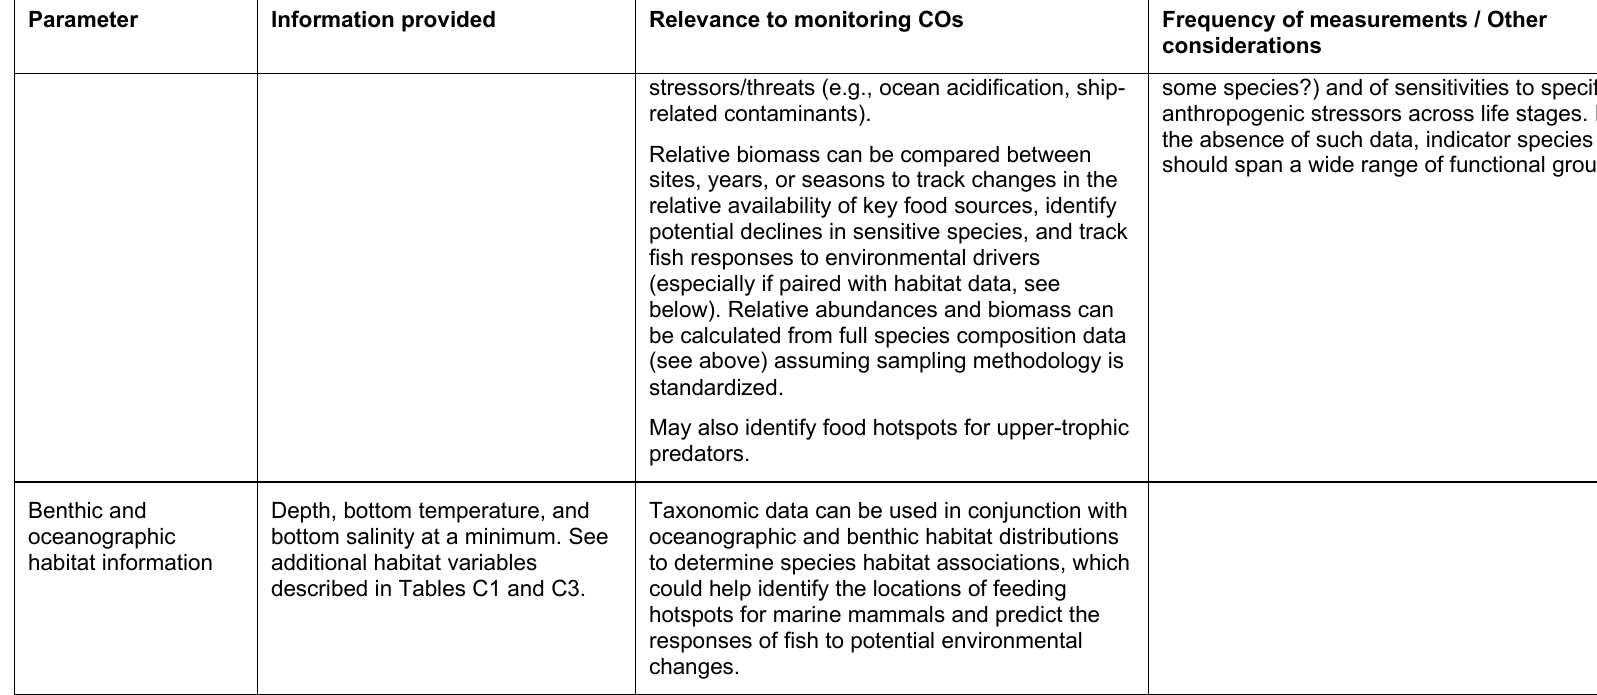
Table C6.6. Key measurement parameters for monitoring inshore fish community composition, structure, and function (Section 6.6).